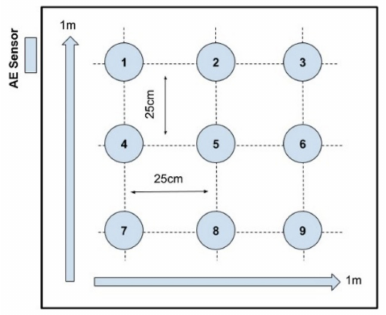
Figure 4. PD location relative to AE sensor.